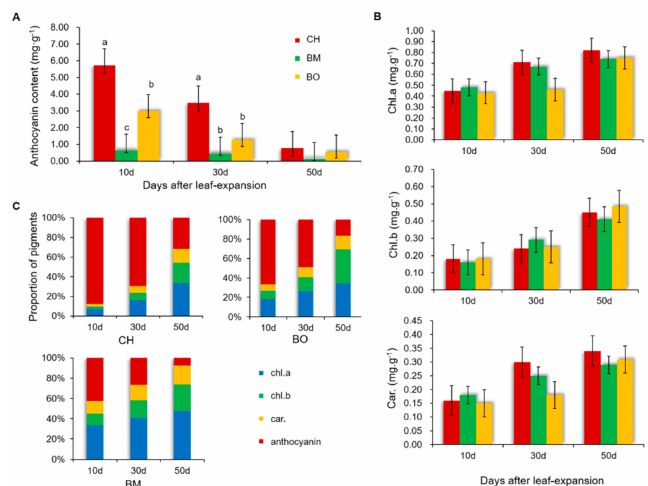
Figure 2. Contents of anthocyanins ( A ), chlorophyll a, chlorophyll b, and carotenoids ( B ) in Camellia japonica cultivars CH, BM, and BO leaves at di ff erent growth stages. ( C ) Proportion of chlorophyll a, chlorophyll b, carotenoids, and anthocyanins in CH, BM, and BO leaves at di ff erent growth stages. Data are means ± standard deviation (SD), n = 3. Di ff erent letters above the bars indicate significant di ff erences ( p < 0.05, one-way ANOVA). Table 1. The correlation between pigment contents and leaf color parameters of three Camellia